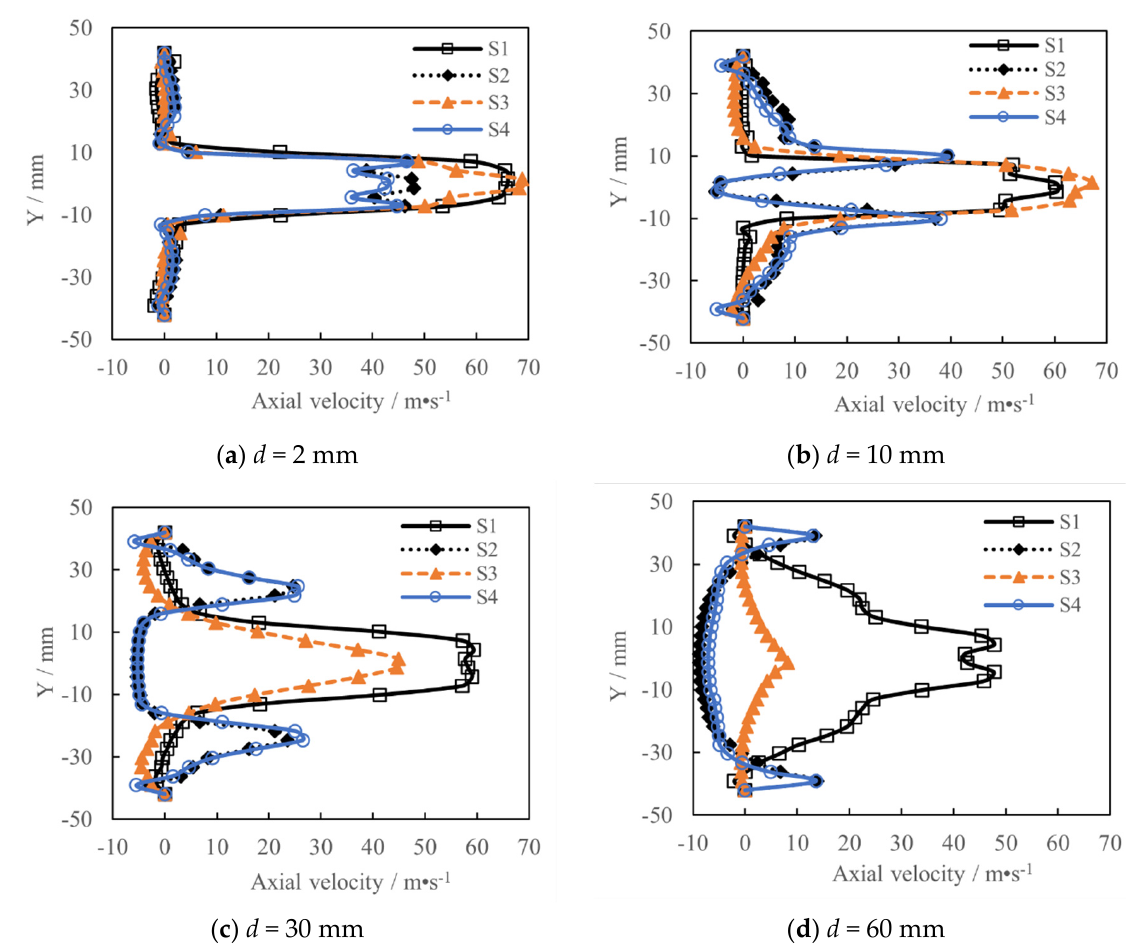
Figure 7. Radial profile of axial velocity at different axial sections.